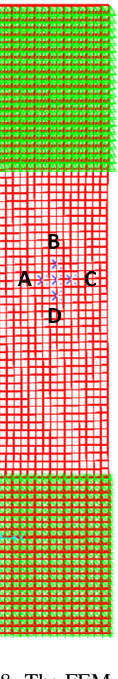
Figure 18: The FEM model.